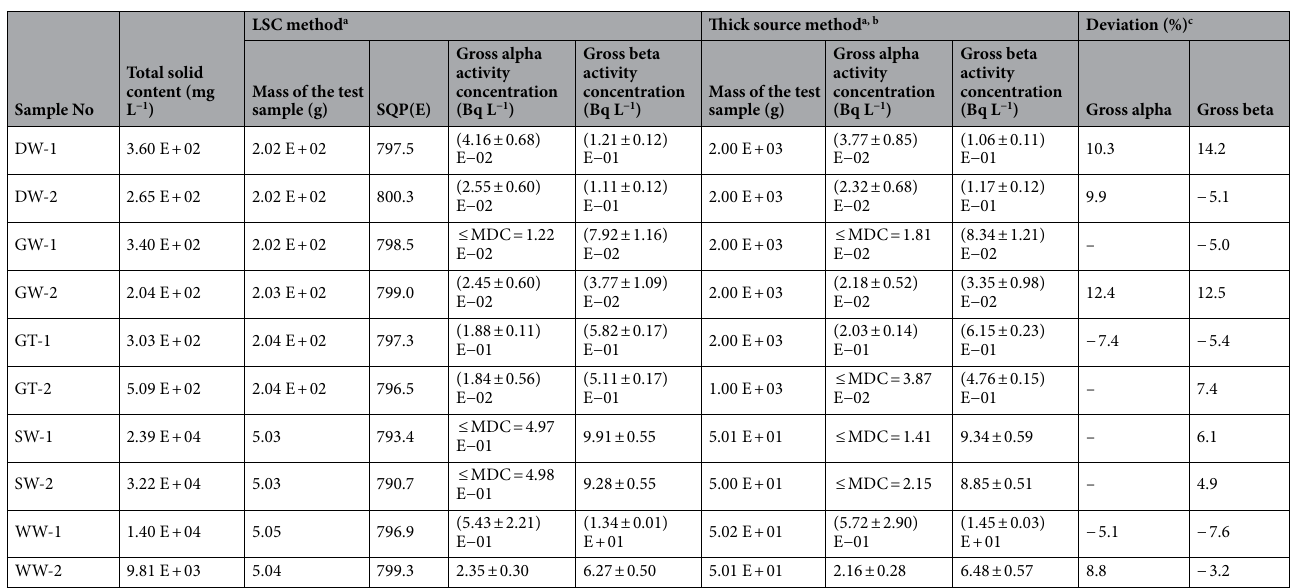
Table 8. The results of gross alpha and gross beta activity concentrations of different kinds of water samples determined using LSC and thick source methods. a The expanded uncertainty corresponds tok = 1. b The measurement time of samples and background are all 10 h. c The deviation of the results of the LSC method relative to the results of the thick source